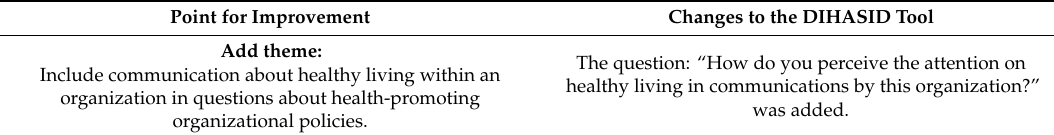
Table 2. Points for improvement suggested in expert interviews and changes to the DIHASID